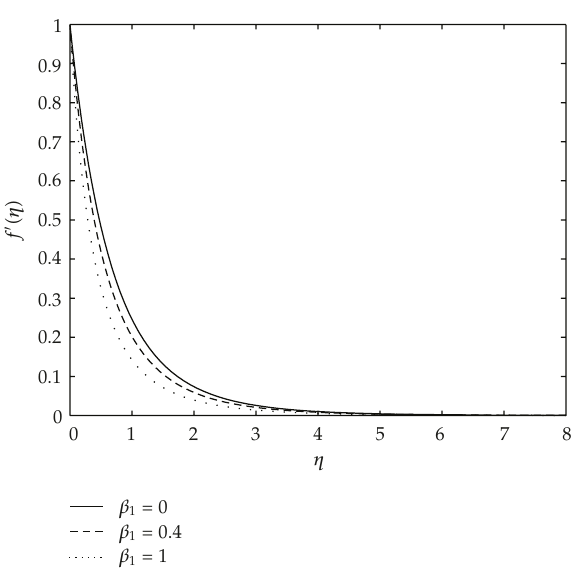
Figure 1: The variation axial velocity distributions with increasing values of β 1 with M (cid:5) 1, Pr (cid:5) 0 . 72, m (cid:5) 1, β 2 (cid:5) 0 . 1, and S (cid:5) 0 .